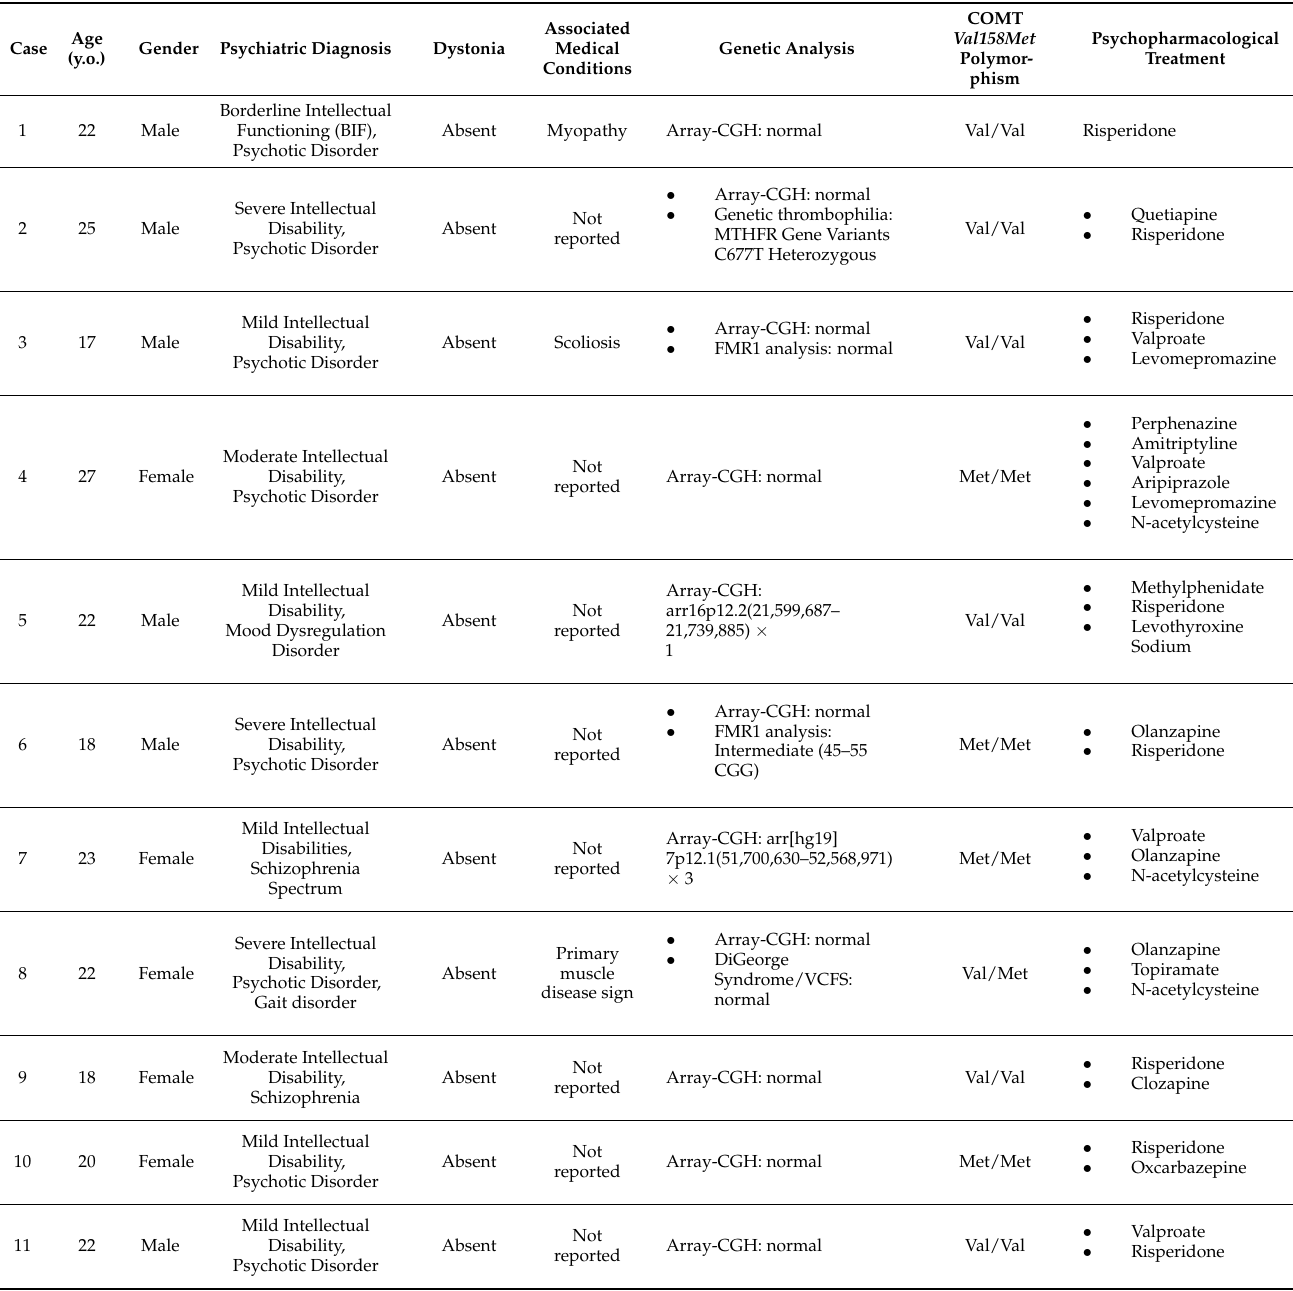
Table 1. Characteristics of APDs-resistant (APDR)